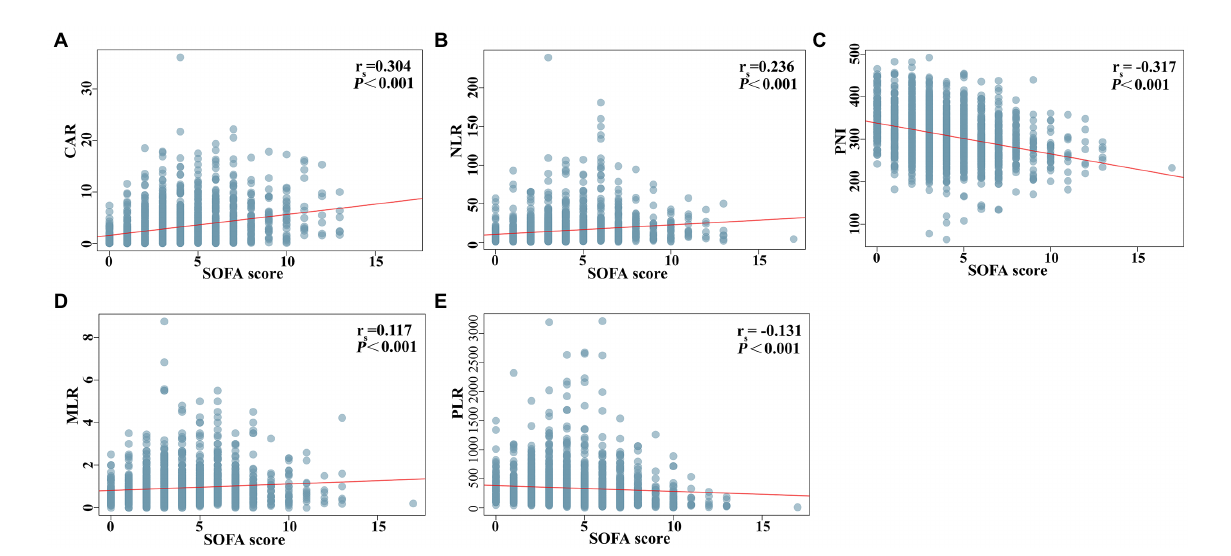
FIGURE 4 Correlation analysis between novel serological biomarkers and SOFA score. (A) CAR, (B) NLR, (C) PNI, (D) MLR, (E) PLR. Correlations between variables were analyzed with Spearman’s coefficients.